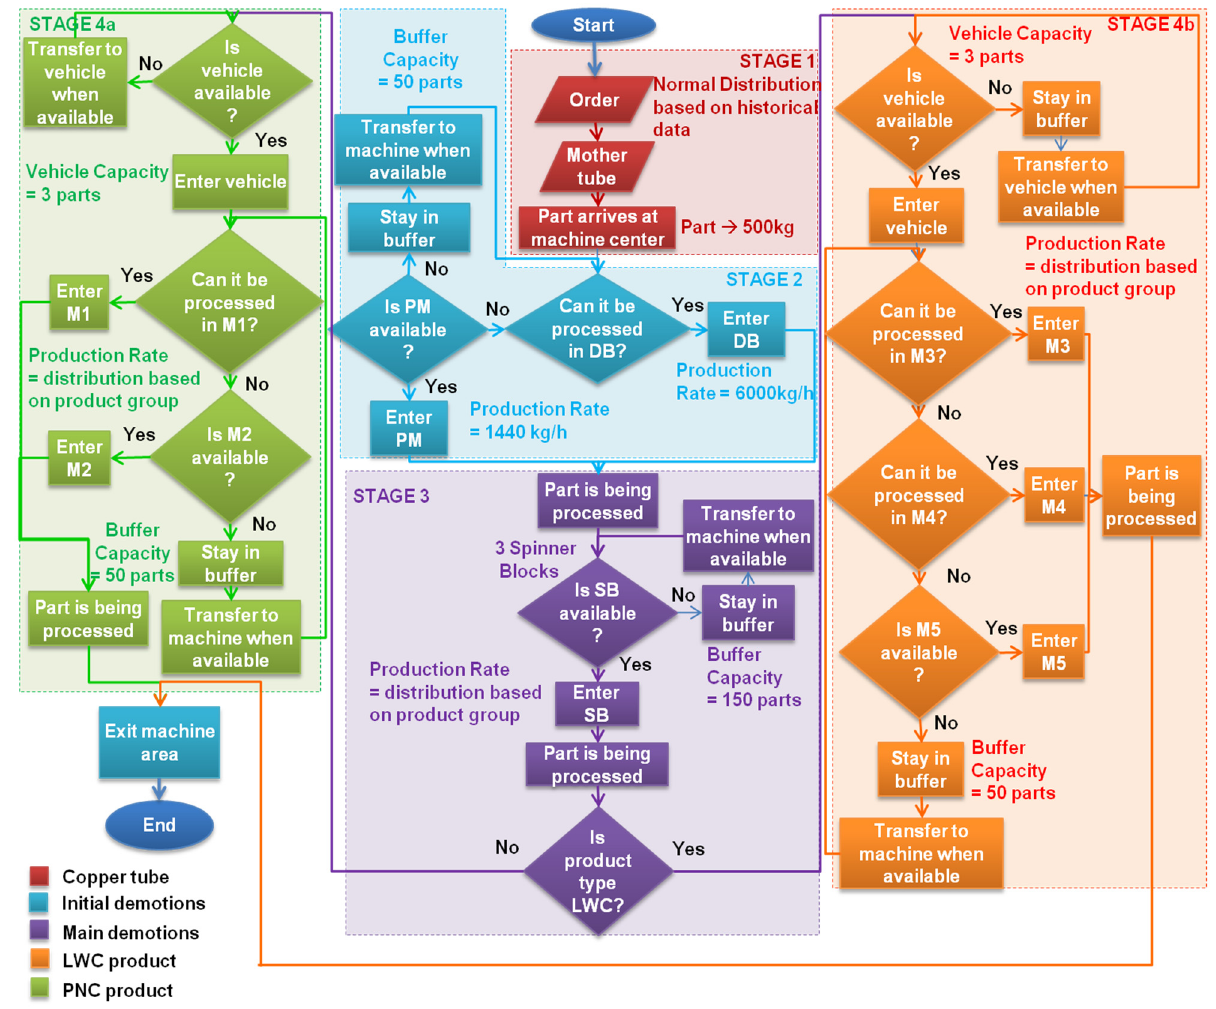
Figure 2. Flowchart of the proposed simulation model .